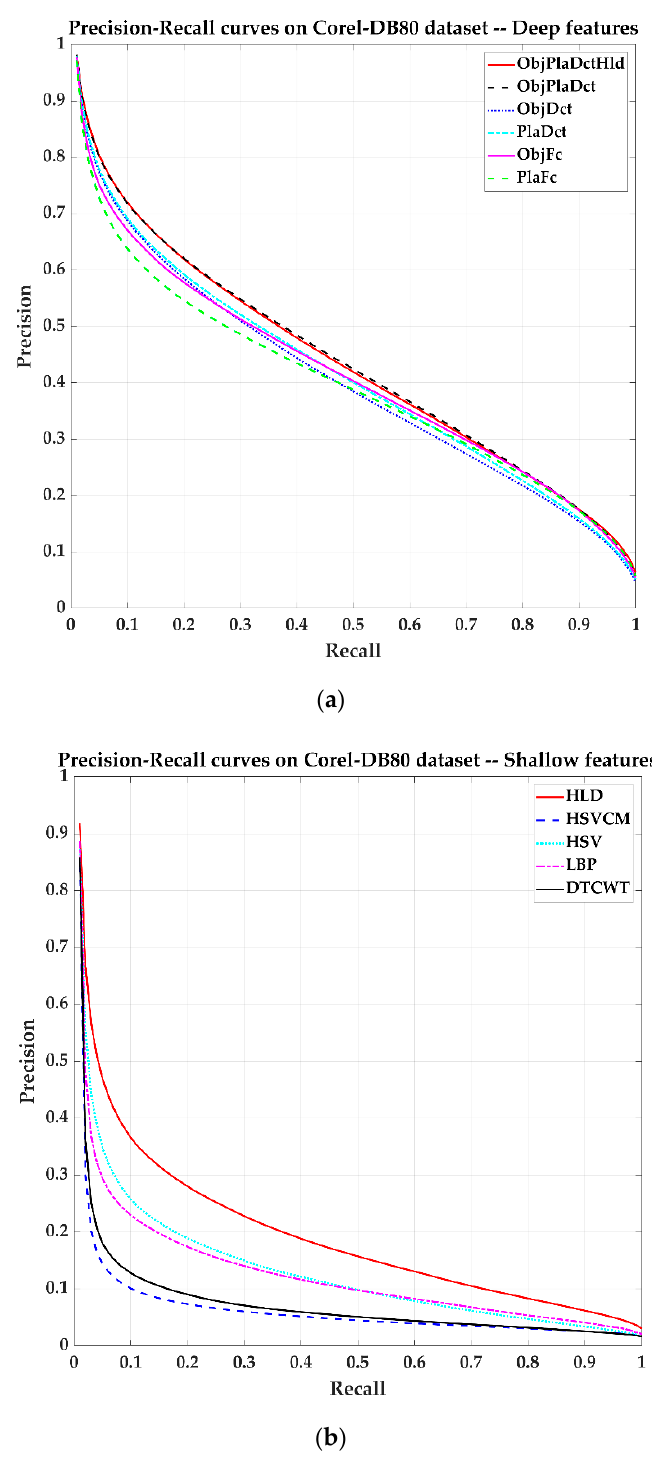
Figure 13. Precision-Recall curves on the Corel-DB80 dataset. ( a ) The methods based on deep features. ( b ) The methods based on shallow features.